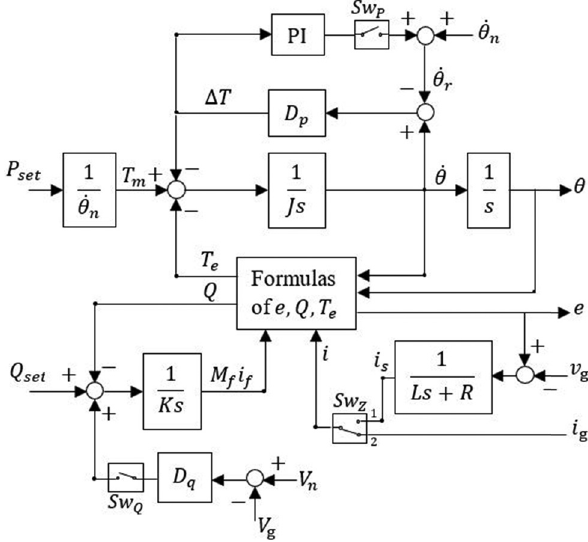
Figure 2: The control part of the synchronverter with the self - syn - chronized loop [ 13 ]